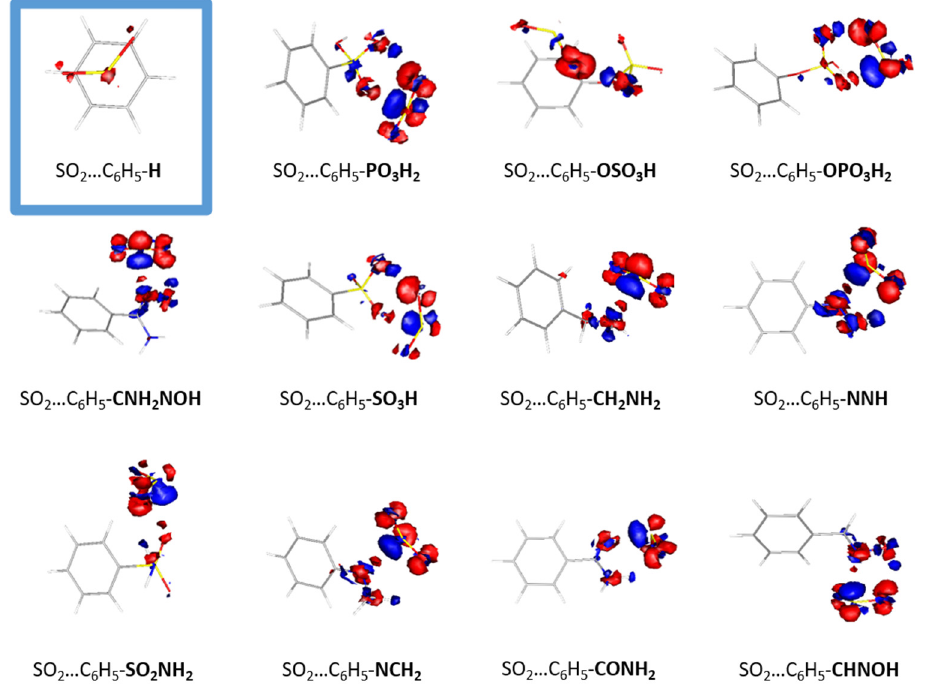
Figure 3. The electron density redistribution plots of the interacting molecules with SO 2.